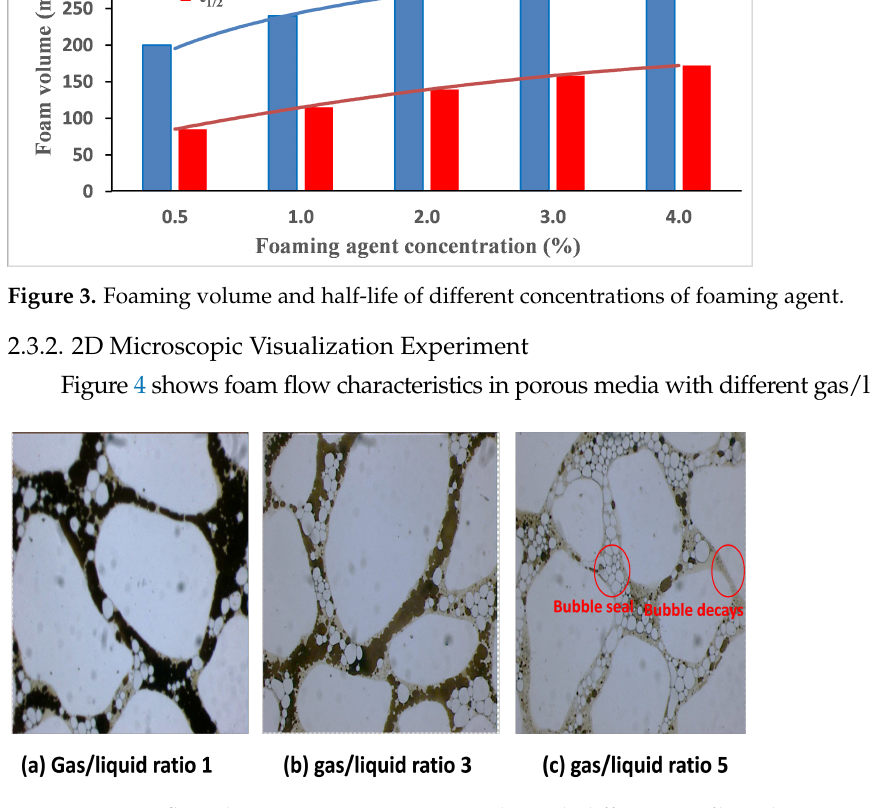
Figure 4. Foam flow characteristics in porous media with different gas/liquid